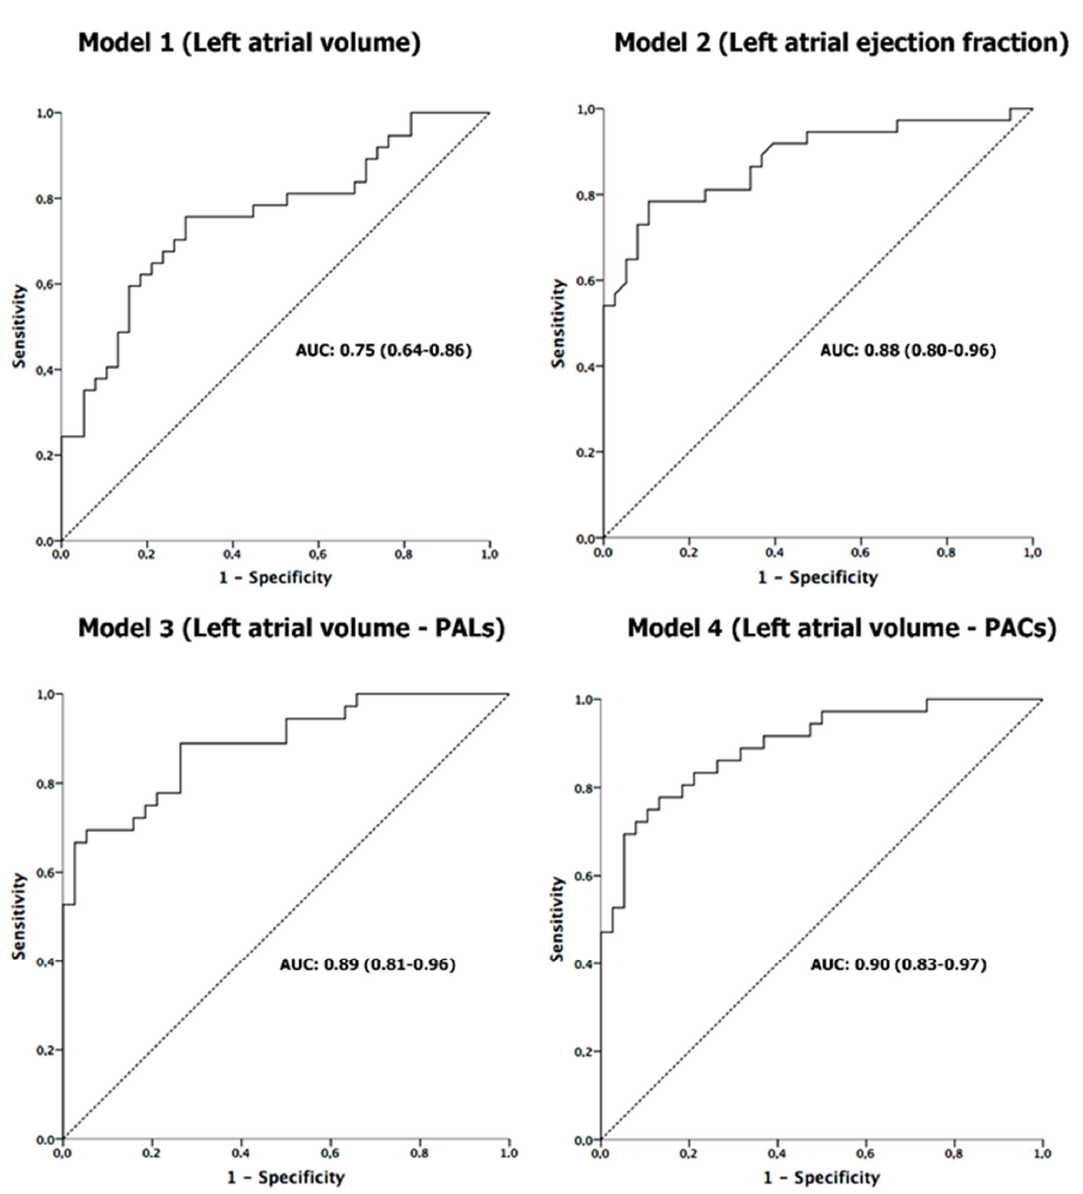
Figure 2. Results of receiver-operating characteristic curve analysis for predicting silent AF in all patients after CrS. AUC: area under the curve.